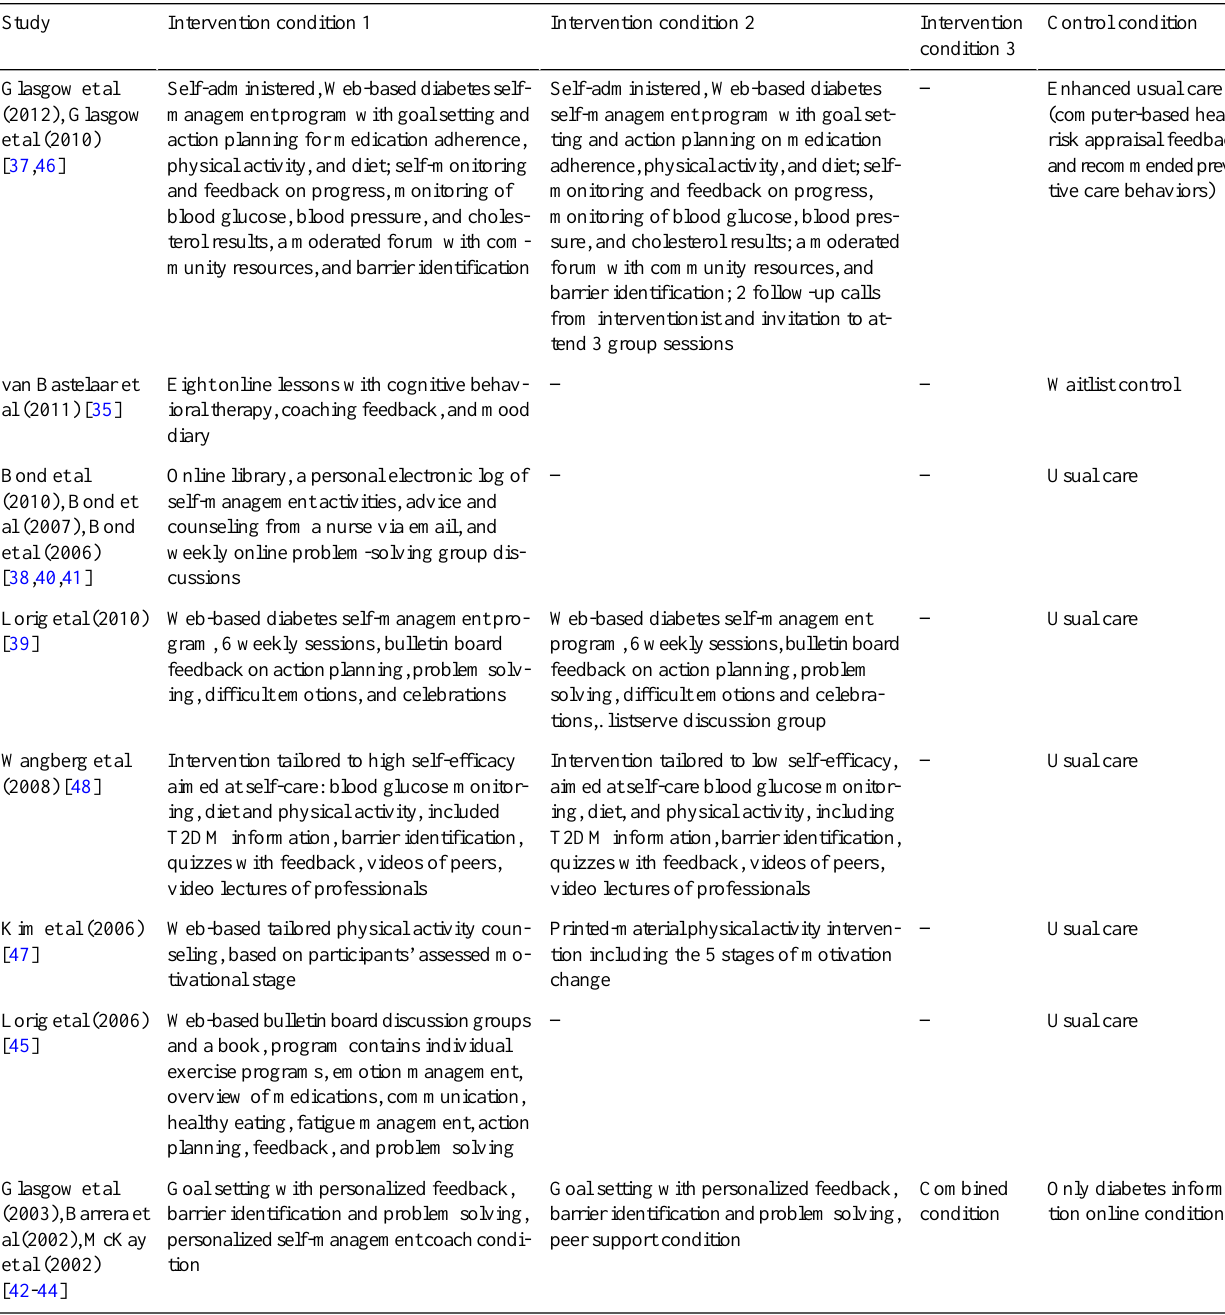
Table 3. Characteristics of interventions and control conditions of the intervention programs.